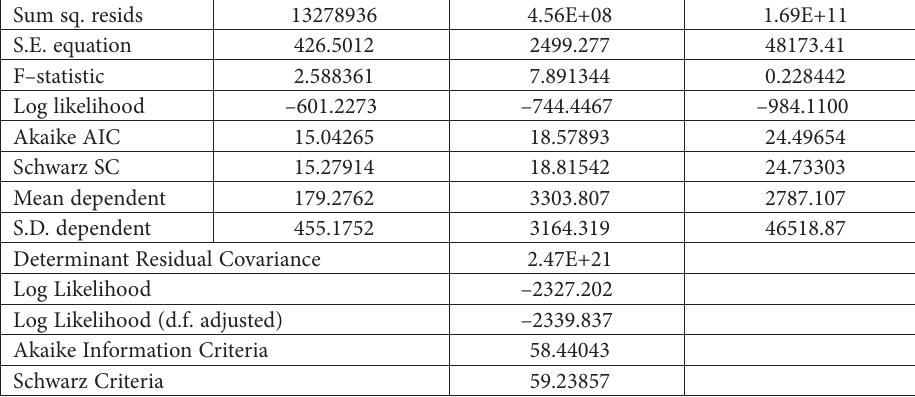
Table A4. VEC Residual serial correlation LM tests (source: authors’